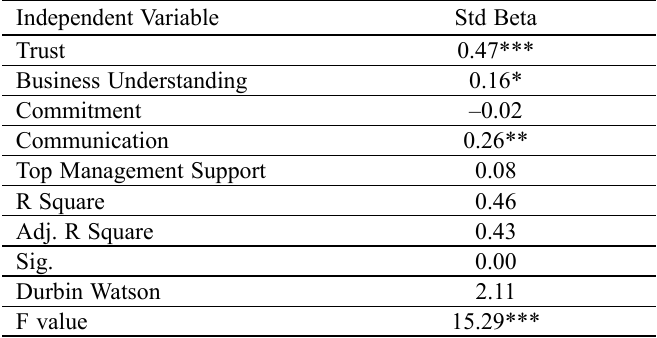
Table 3. Regression for partnership quality and outsourcing